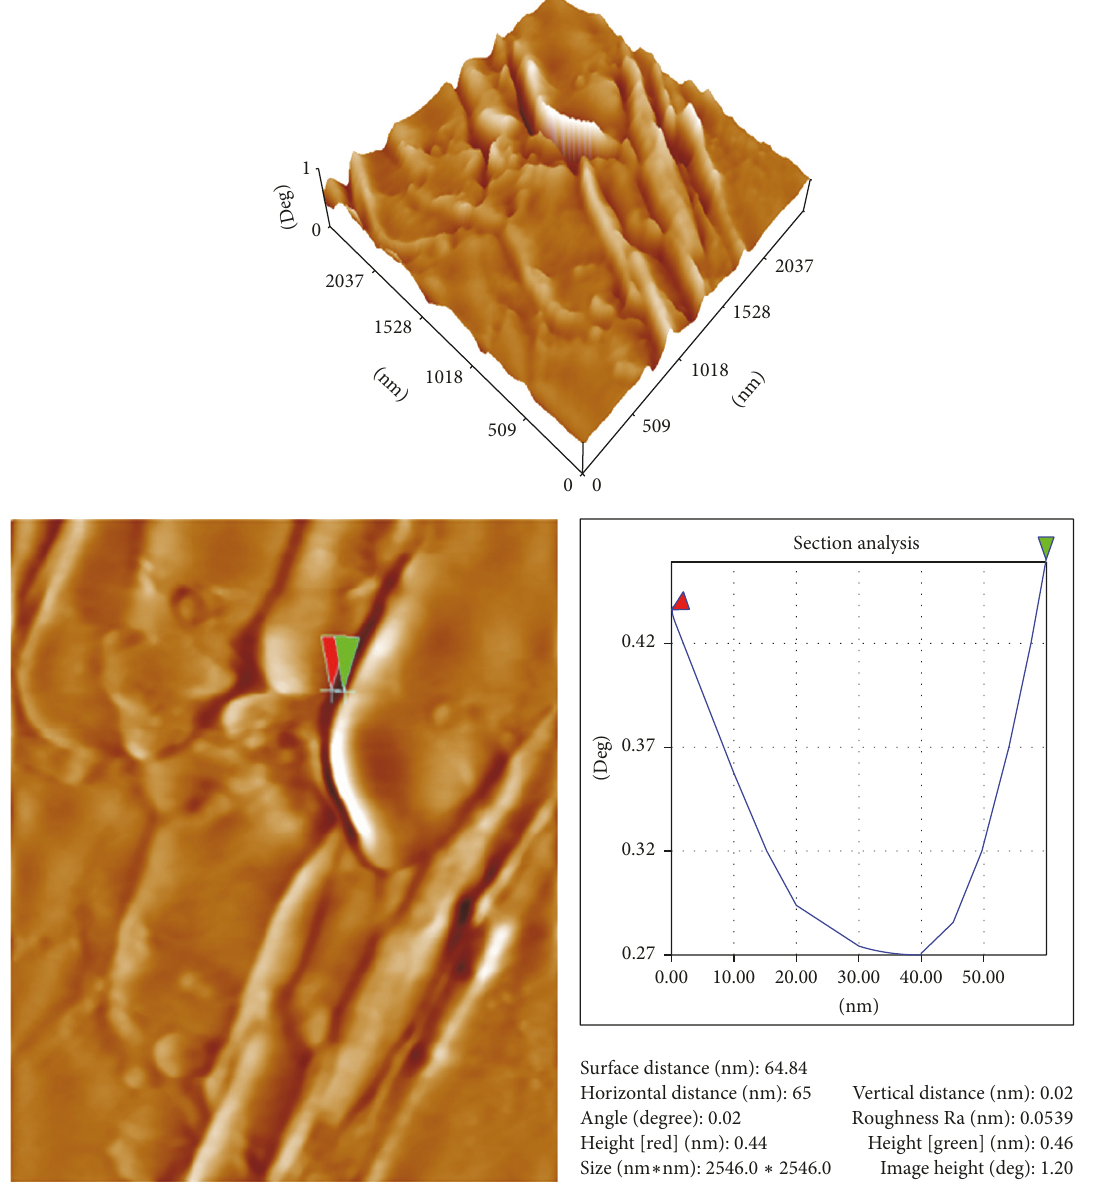
Figure 4: AFM images show the 3D and section line analysis of GO produced by modified Hammers method from graphite